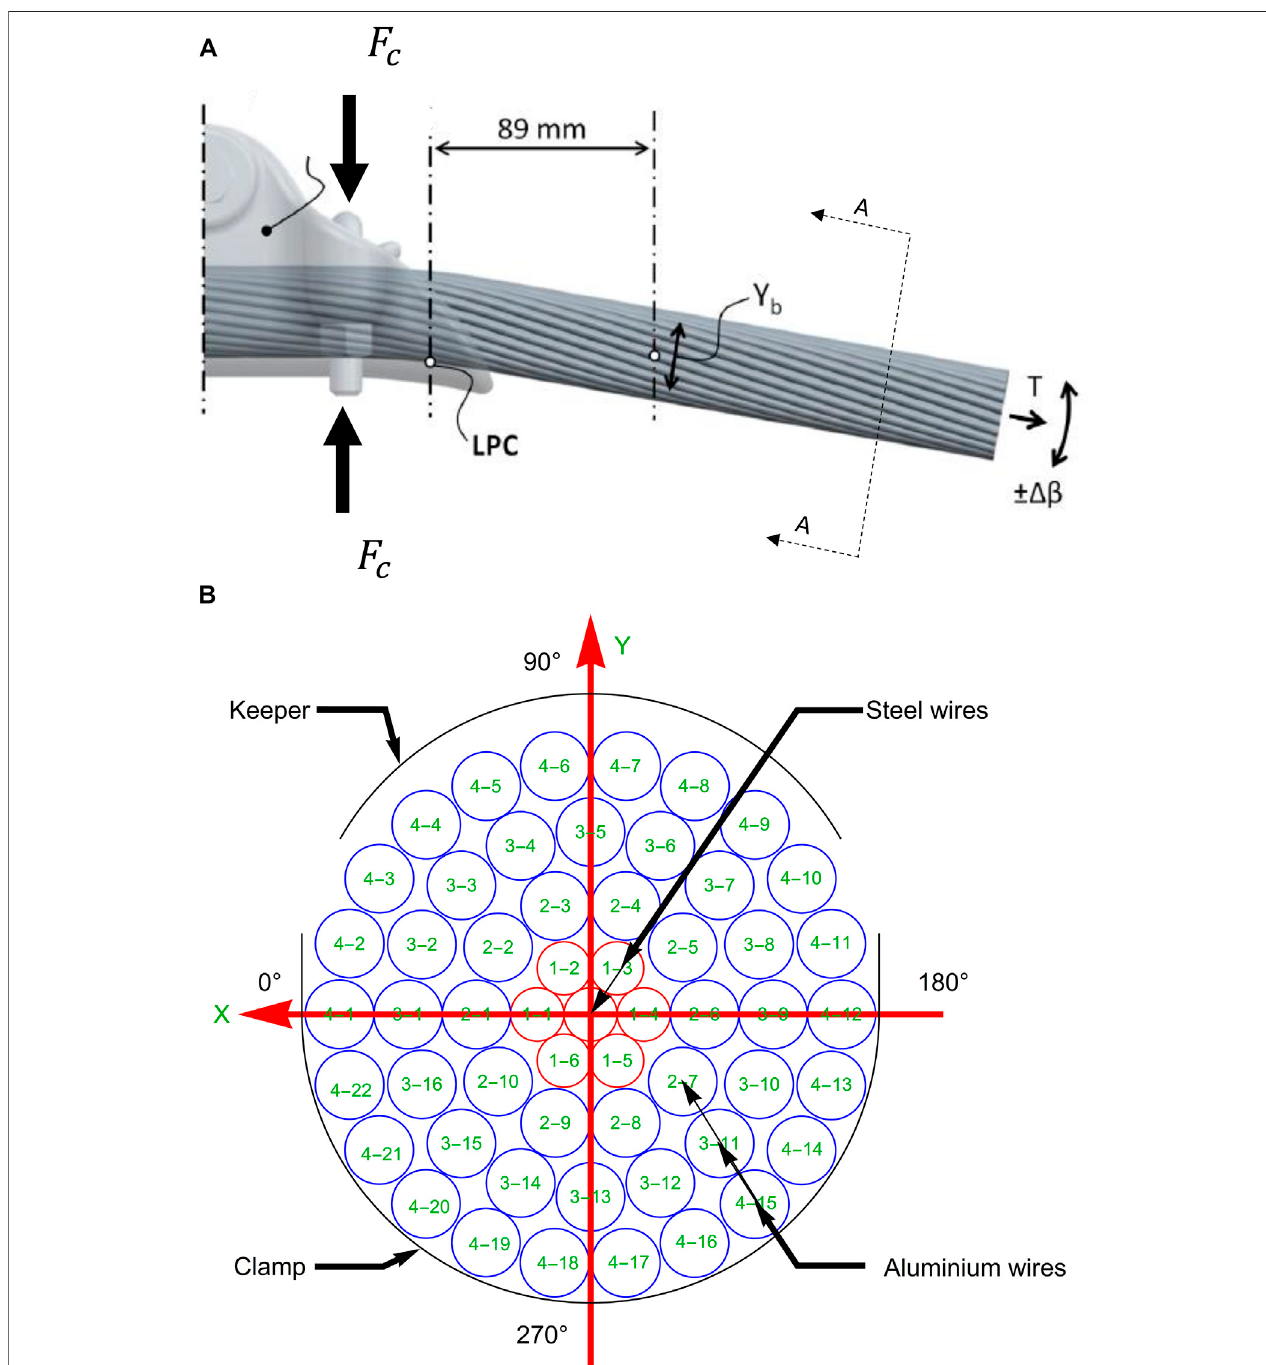
FIGURE 1 | (A) Typical conductor-clamp assembly with applied conductor tension (T), clamping force ( F C ), change in alternating bending angle ( Δ β ), and bending amplitude (Yb) [adapted from Lalonde et al. (2018)]. (B) Cross-section A-A of a typical conductor-clamp assembly showing the steel wires, aluminum wires, keeper and clamp con fi guration, and the wire numbering